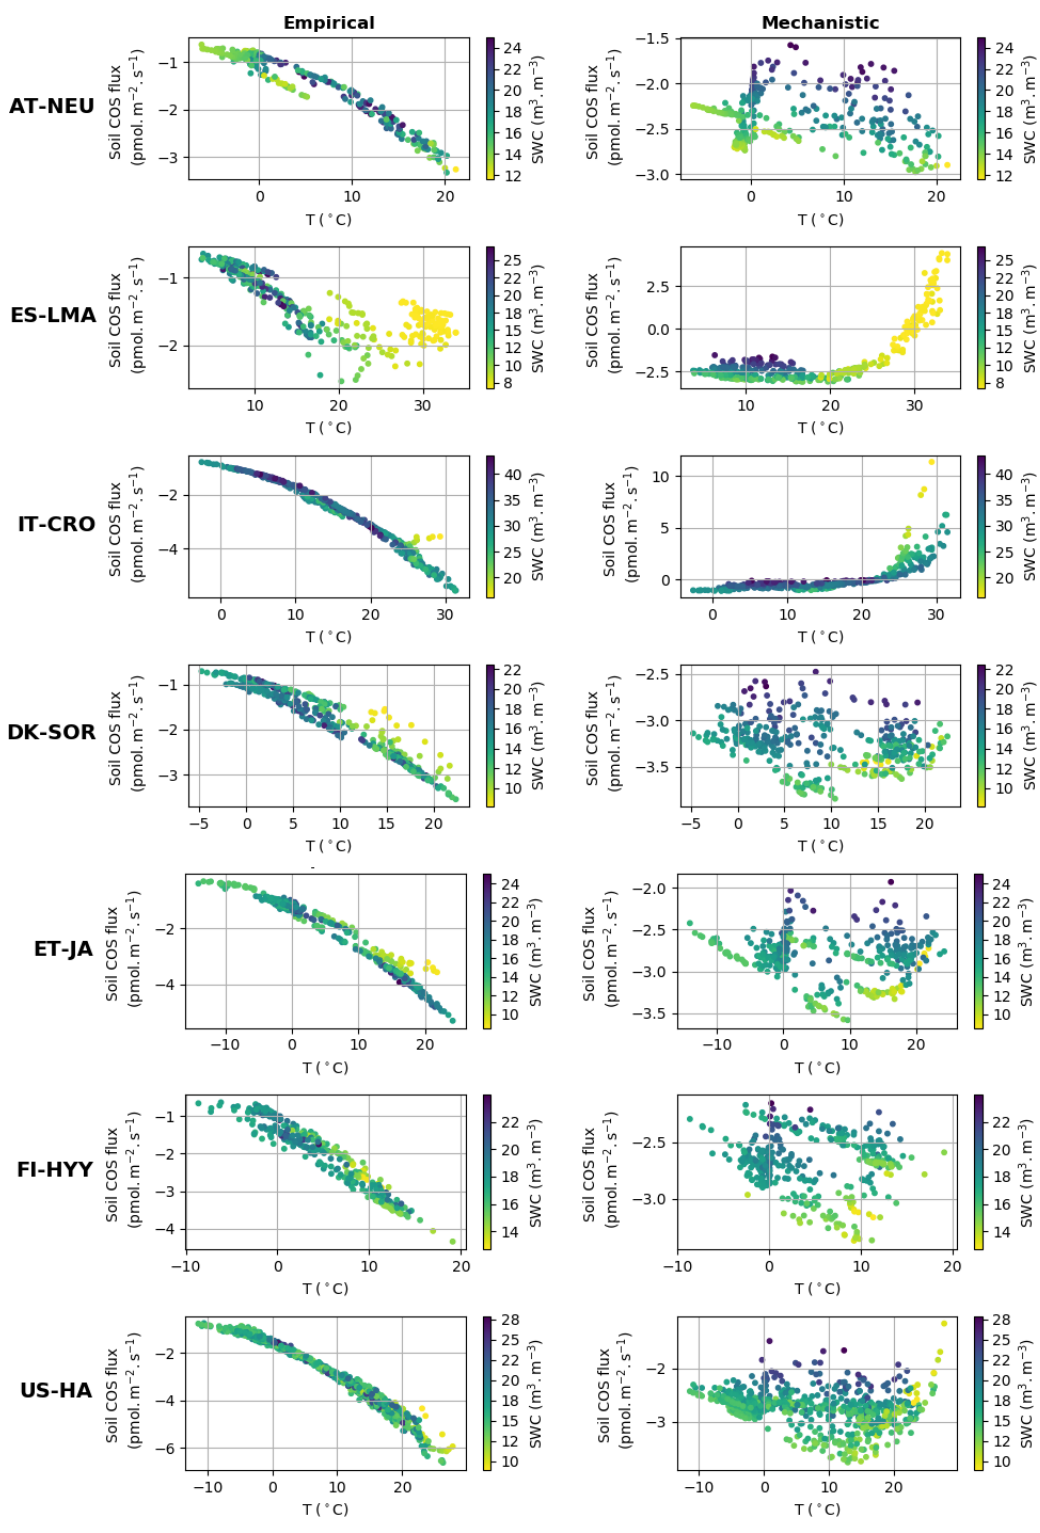
Figure 4. Simulated daily average net soil COS flux (pmolm 2 s − 1 ) versus soil temperature ( ◦ C) and soil water content (SWC) (m 3 m − 3 ) at AT-NEU, ES-LMA, IT-CRO, DK-SOR, ET-JA, US-HA, and FI-HYY, for the empirical and the mechanistic model.